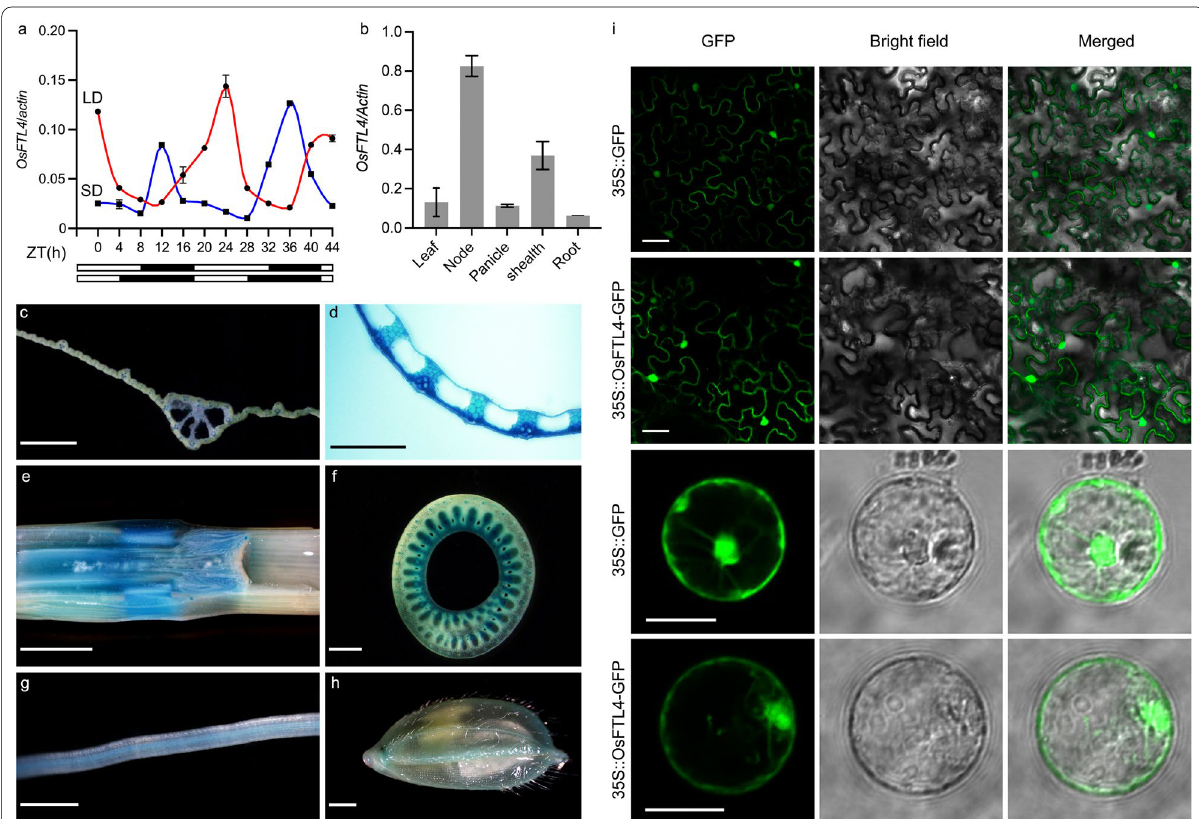
Fig. 3 OsFTL4 expression profile. a Diurnal OsFTL4 expression pattern under SD and LD conditions. b OsFTL4 transcript levels in different tissues. c OsFTL4 promoter-GUS activity was detected in the leaf. d Sheath. e Node. f Stem. g Root. h Mature spikelet before fertilization. Scale bars: c 0.5 mm; e 5 mm; d , f – h 1 mm. i Subcellular localization of OsFTL4 in Nicotiana benthamiana leaf epidermal cells and rice protoplasts. Scale bars, 50 μm in N. benthamiana and 20 μm in